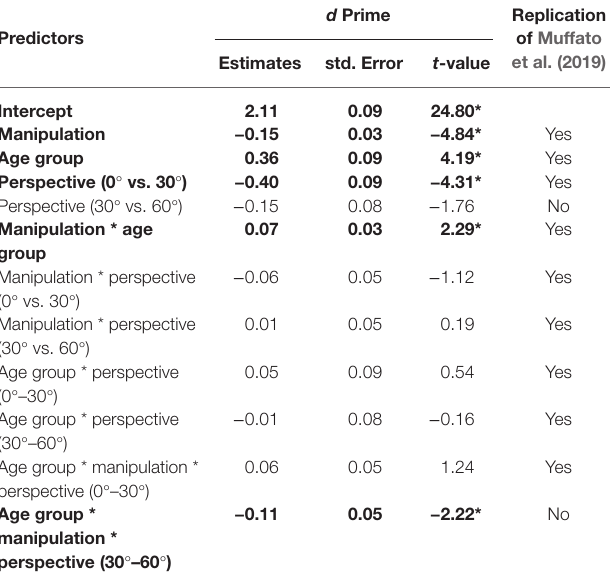
TABLE 2 | Linear mixed effect (LME) model for d ’ scores.